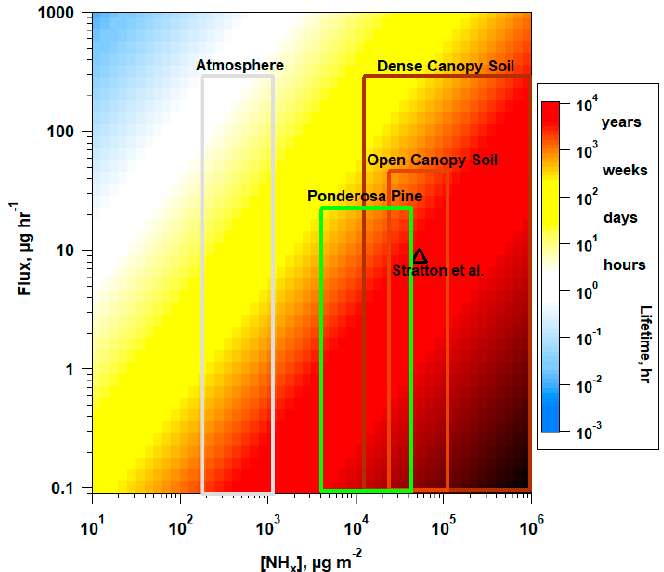
Figure 8. Lifetime of NH x in h with respect to soil ‒ atmosphere exchange as a function of NH x concentration and flux in µ g m − 2 h − 1 on logarithmic scales. The ranges of measured [NH x ] content and inferred fluxes for the atmosphere, Ponderosa pine, dense and open canopy soils are highlighted.